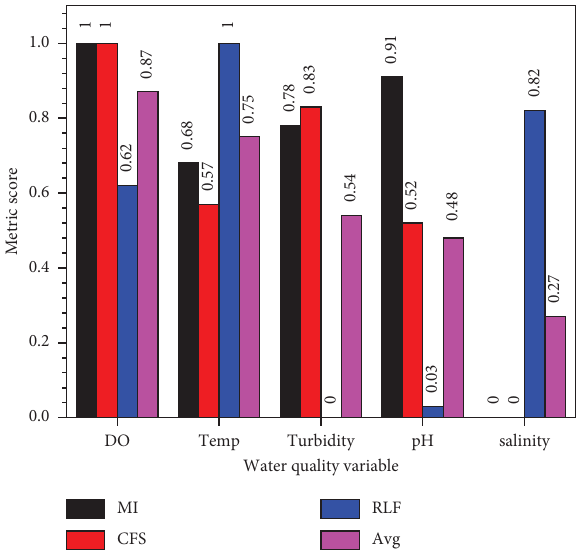
Figure 4: Considering yield as the major indicator, the efect of water quality factors on harvest result.